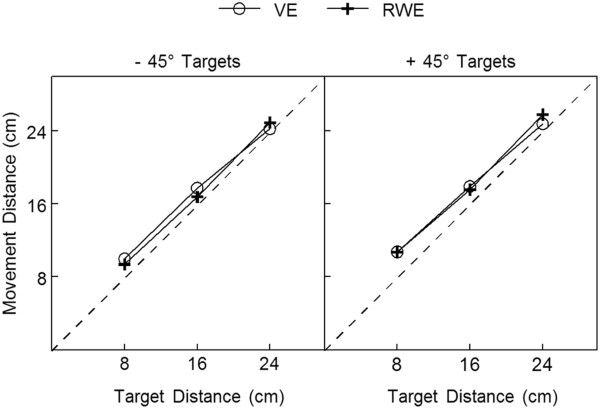
Mean movement distance by reach direction in both environments. Markers indicate group means with standard error bars. Dotted line indicates perfect scaling of movement distance to target distance. VE = virtual environment; RWE = real-world environment. Note that standard error was small across distances (<0.9 cm) and within the size of the markers.